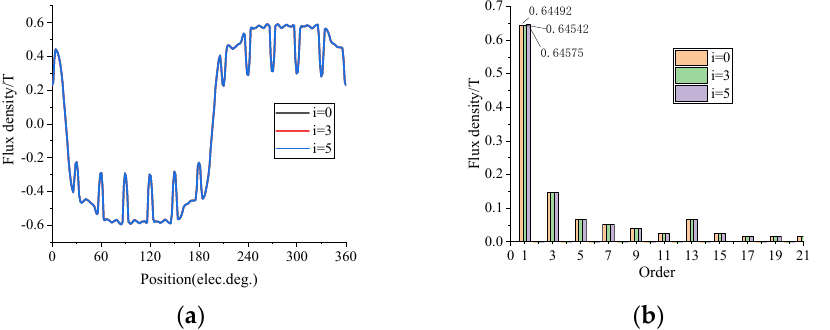
Figure 18. Air gap flux density of the motor under different excitation currents. ( a ) Waveform of air gap flux density; ( b ) harmonic spectra.